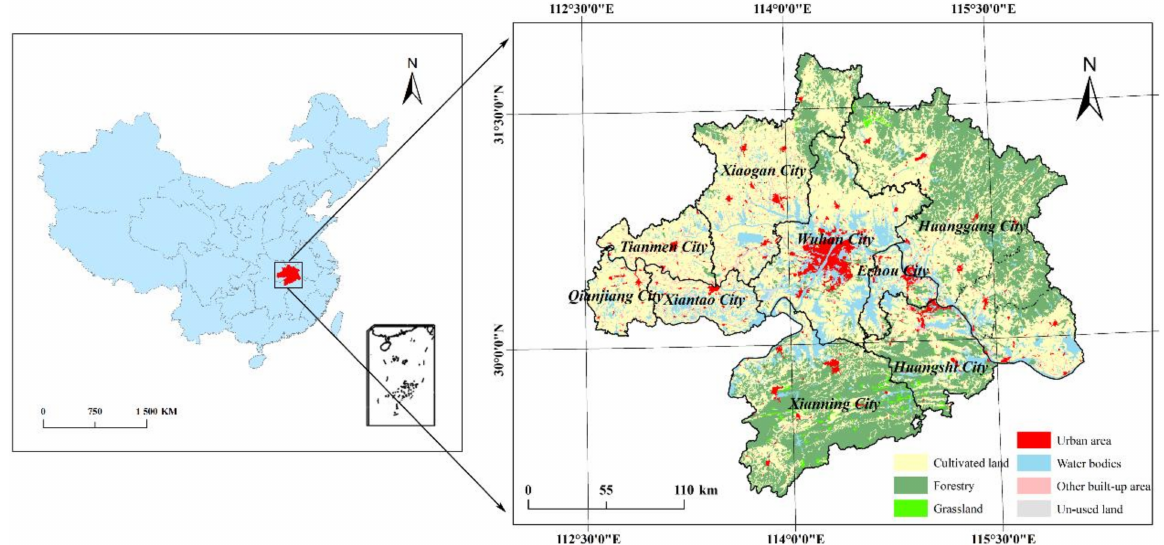
Figure 2. Location of the Wuhan City Circle and its land-use status of